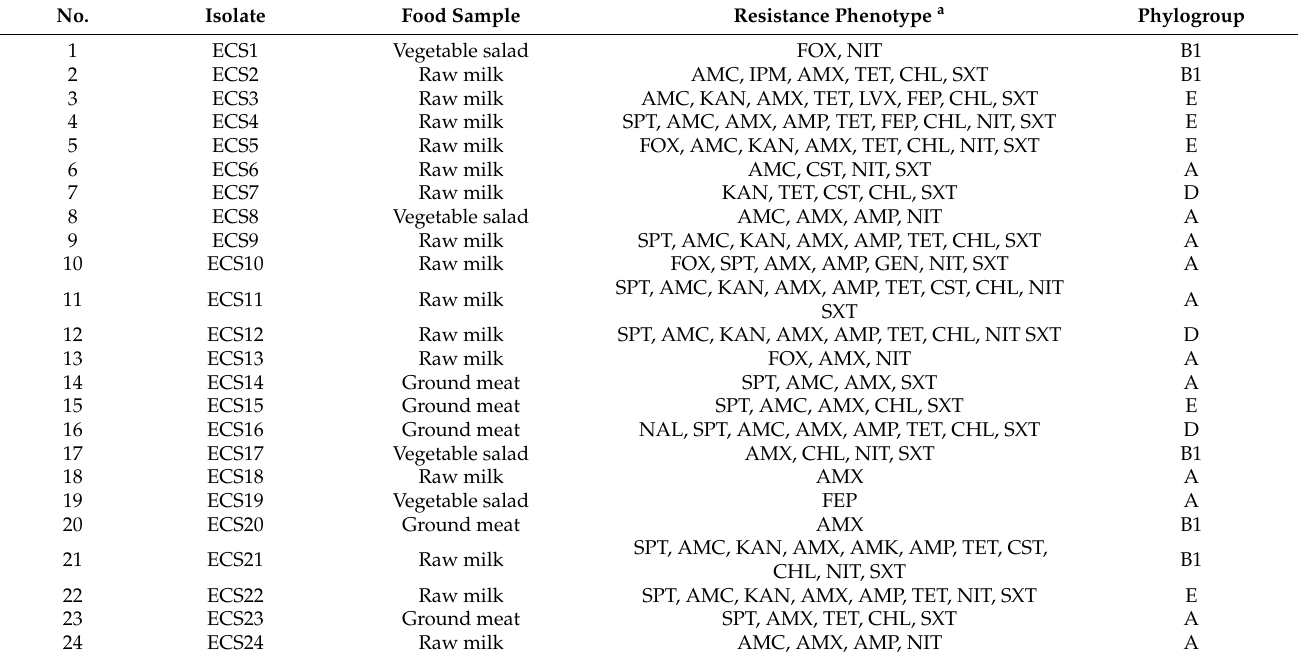
Table 4. Distribution of phylogroups among the E. coli isolates obtained from different food products. No.